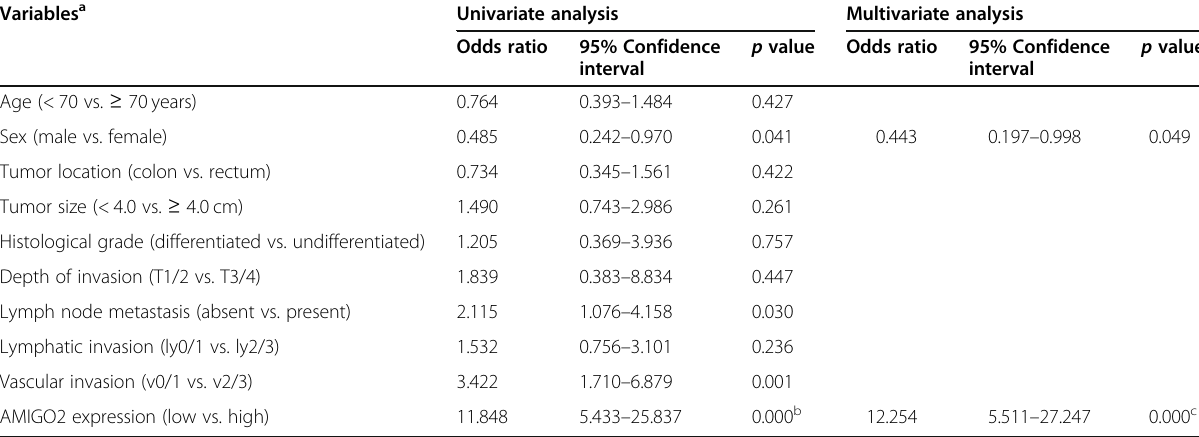
Table 3 Univariate and multivariate analysis of factors affecting liver metastases in CRC patients (Logistic regression model) Variables